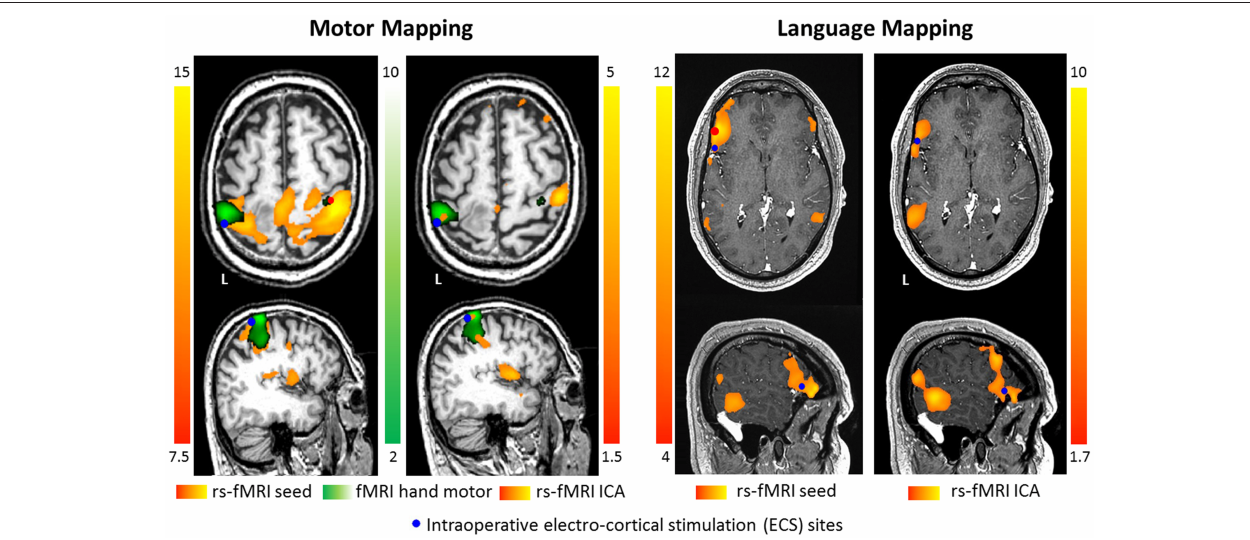
FIGURE 1 | Motor mapping was performed in a surgical patient using rs-fMRI with motor seed (in red, placed in the healthy Rolandic cortex), rs-fMRI ICA, a finger tapping motor task and ECS data (patient 12 in Rosazza et al. (44)). Results showed that seed-based analysis, ICA and tb-fMRI, provide comparable but not equivalent results; nevertheless, the stimulation site (in blue) was included in each activation pattern. In another surgical patient language mapping was performed using rs-fMRI with language seed (in red, placed in the left inferior frontal gyrus), rs-fMRI ICA and ECS data (patient 6 in Zacà et al. (47)). Results showed that seed-based analysis and ICA provided similar but not equivalent results; however, stimulation site (in blue) was included in the pattern of correlated